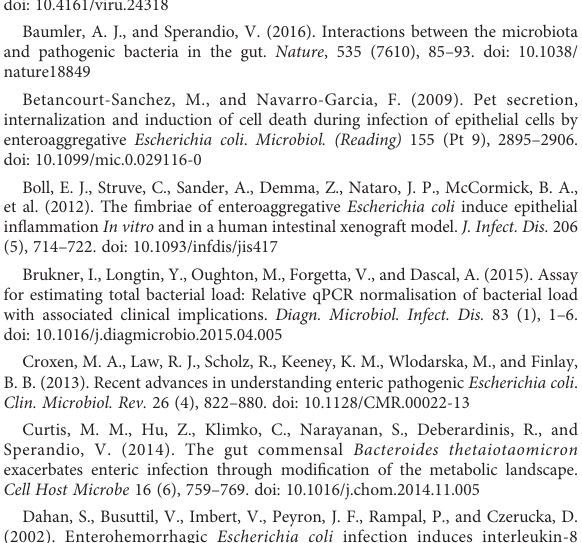
SUPPLEMENTARY TABLE 2 Changes in gene expression determined by RNA-seq, for STEC and EAEC after incubation with EA or CW